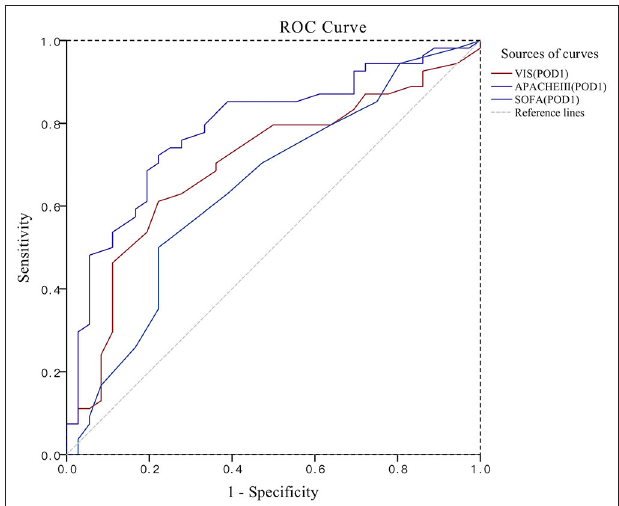
FIGURE 1 | ROC plot for the comparison of three scores. POD1, the first postoperative day; APACHEIII, acute physiology and health score; SOFA, sequential organ failure assessment; VIS, vasoactive-inotropic score.